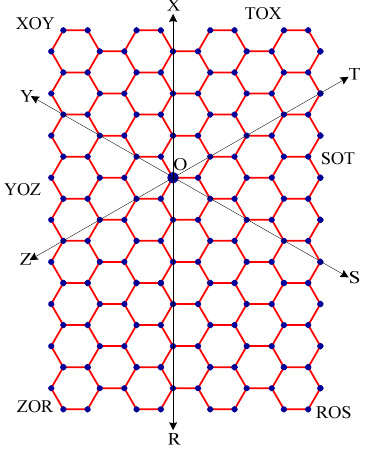
Figure 7. The rectangular sheet is divided into 6 zones: zones ROS, SOT, TOX, XOY, YOZ and ZOR. For example, zone ROS is a subgraph induced by the edges lying between the lines OR and OS.